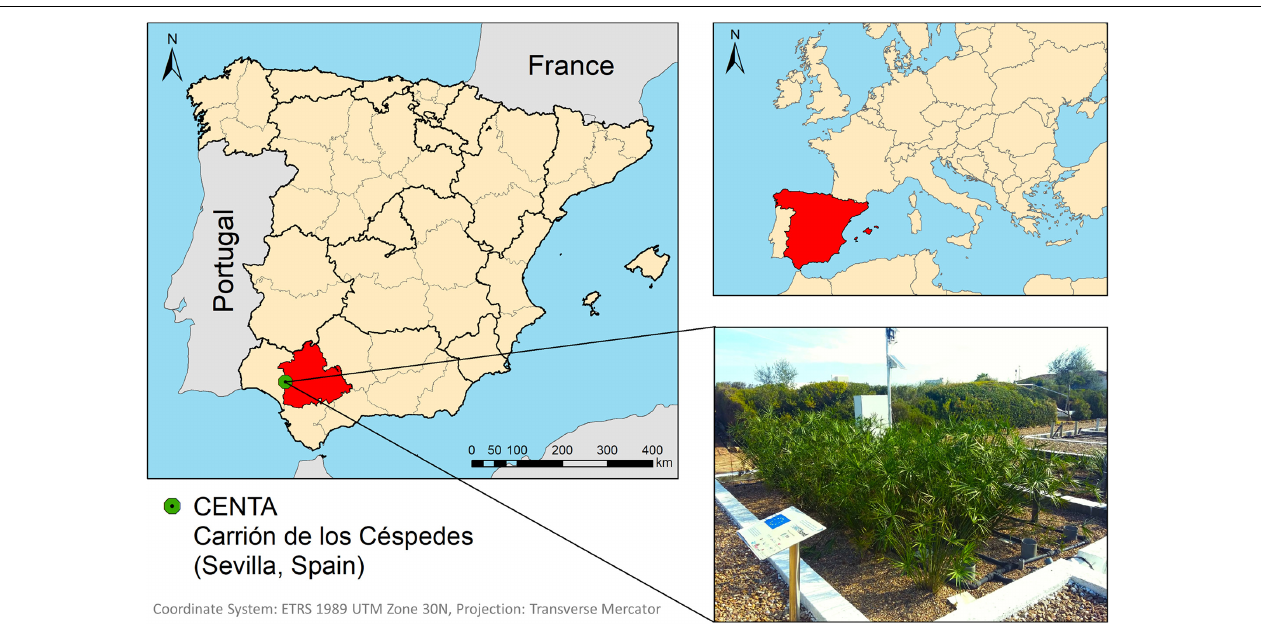
FIGURE 1 | Location of the METland R (cid:13) unit at Municipal WWT plant (Carrión de los Céspedes, Spain).